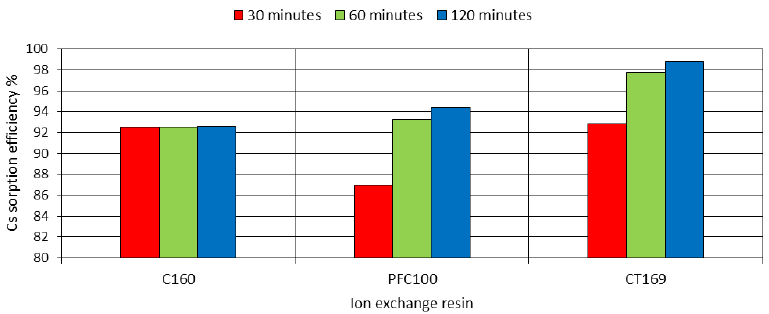
Figure 1. Influence of contact time on cesium ion sorption efficiency.